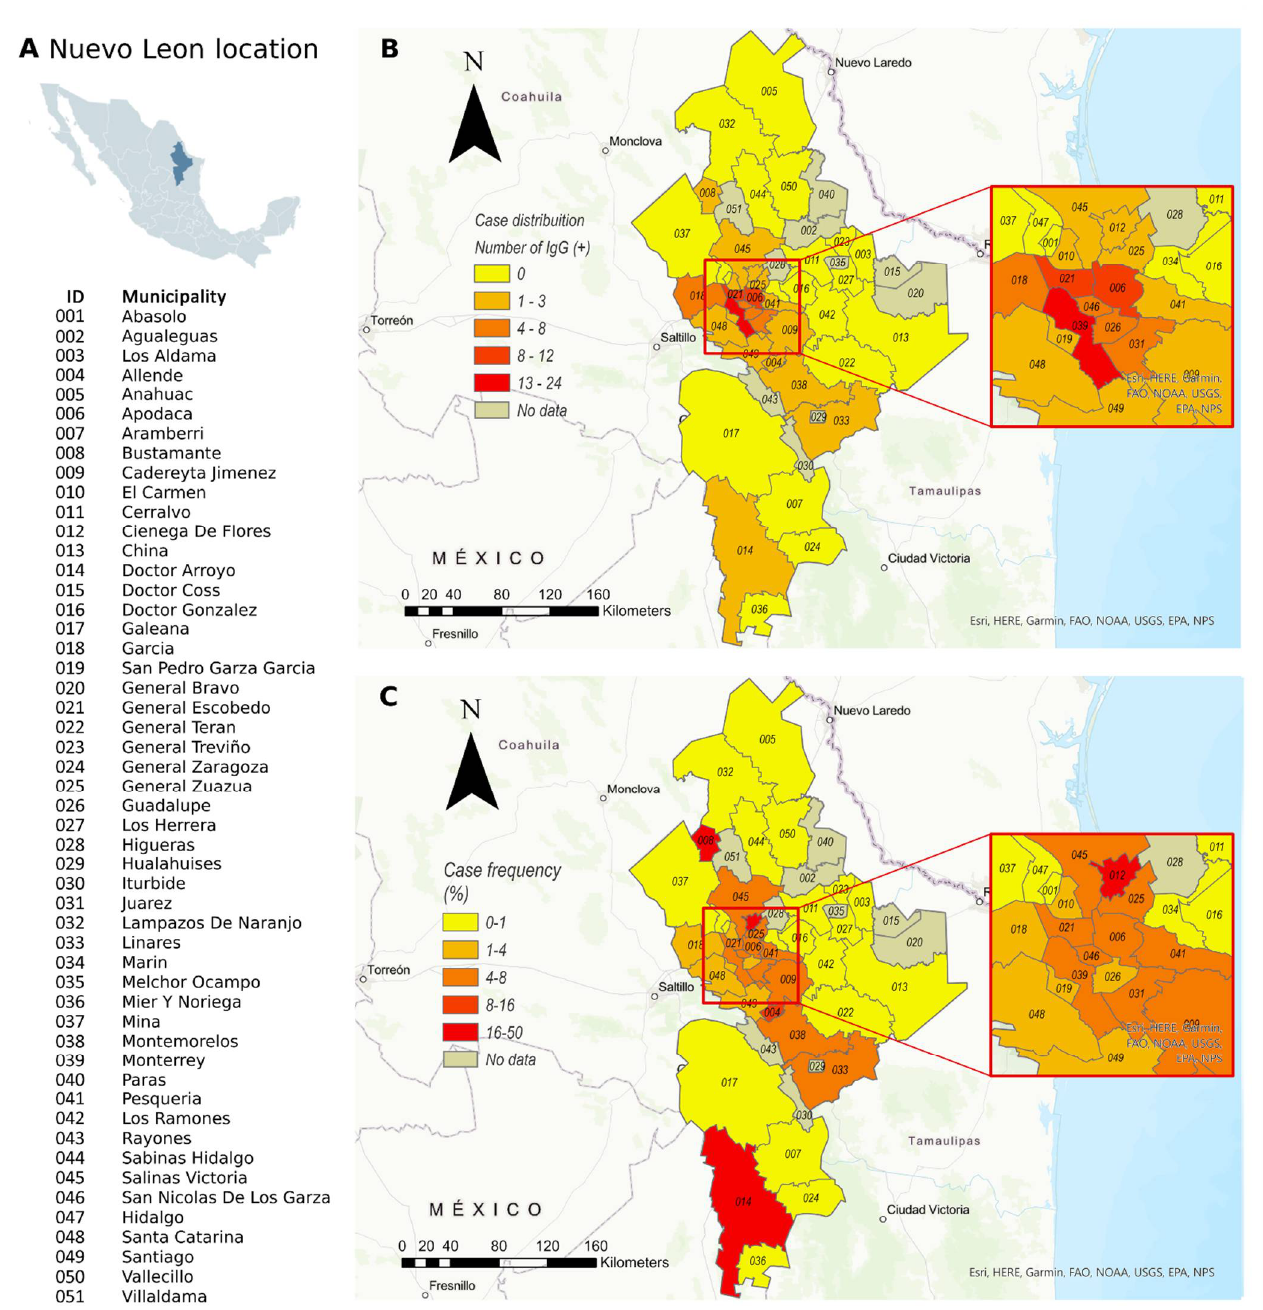
Figure 4. Geographical distribution of asymptomatic SARS-CoV-2 infection events determined by anti-SARS-CoV-2 IgG detection in the Nuevo Leon area. ( A ) Location of Nuevo Leon State in Mexico and municipalities. ( B ) Absolute number of cases per municipality detected during our study. ( C ) Proportion of cases to samples per municipality.